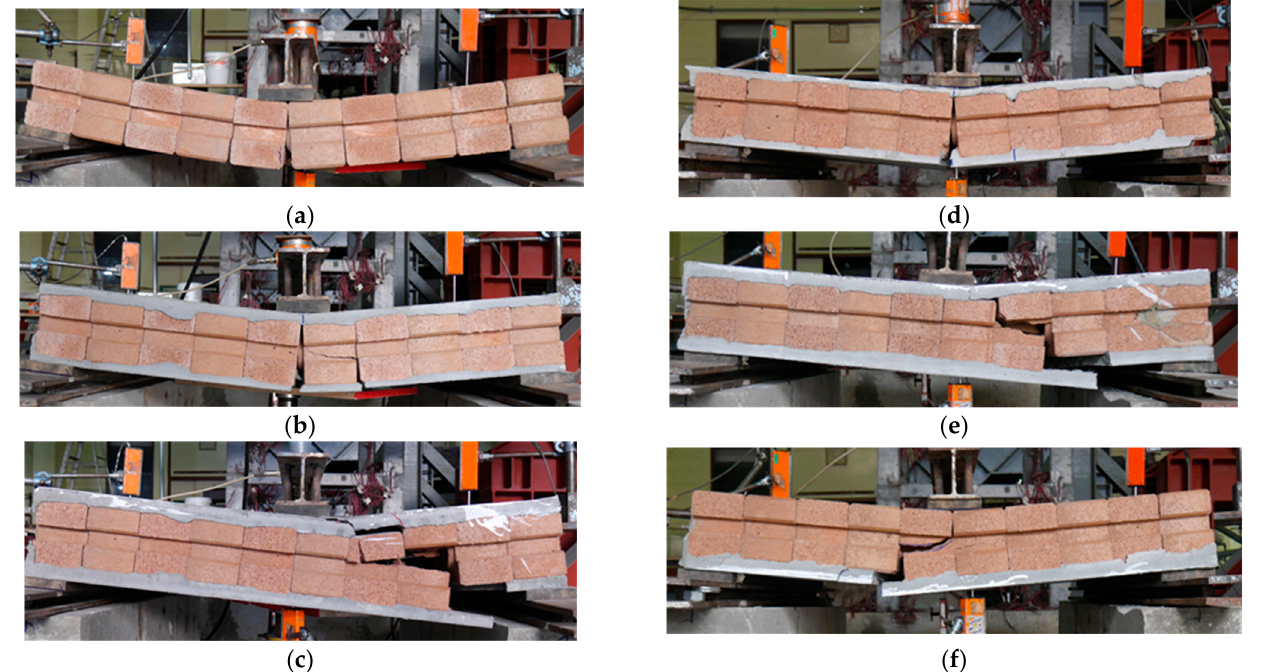
Figure 9. Ultimate failure modes of the CCIB masonry walls: ( a ) MW-CON; ( b ) MW-CS10-A; ( c ) MW-CS20-A; ( d ) MW- CS10-A-WM-1L; ( e ) MW-CS20-A-WM-3L; ( f ) MW-CS20-B-WM-3L.